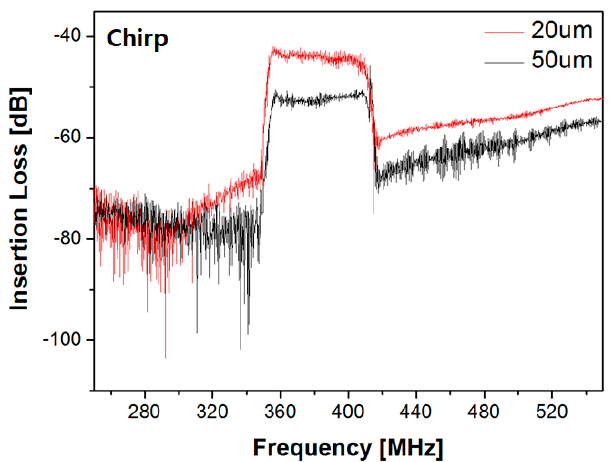
Figure 7. Experimental insertion loss (S 21 ) vs. frequency in terms of LN thicknesses from ( a ) slanted IDT and ( b ) chirp IDT.